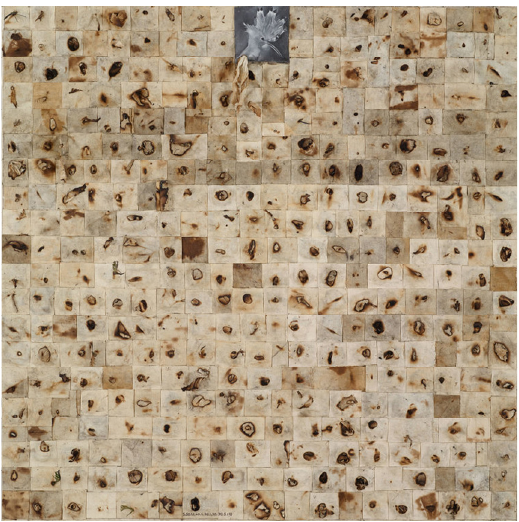
Figure 9. Hanaa Malallah, Portrait (HOOPOE), 2010. Folded burnt canvas, mixed media and oil color on canvas. 100 × 100 cm. © Hanaa Malallah.